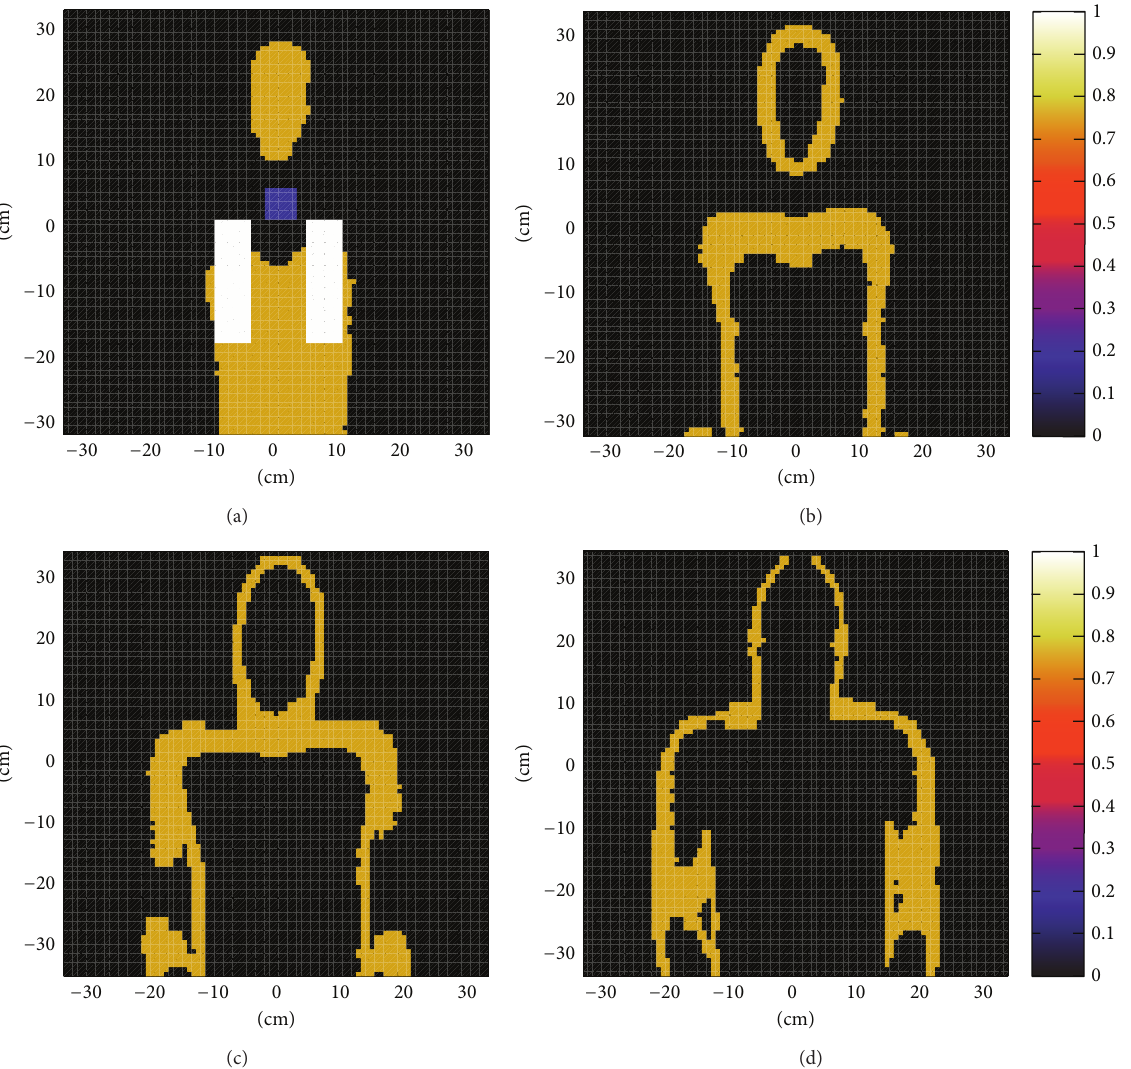
Figure 4: Projected images of the person under test, used as ground truth by the imaging algorithm, at four different ranges: (a) 𝑥 0 + 0 mm, (b) 𝑥 0 + 30 mm, (c) 𝑥 0 + 60 mm, and (d) 𝑥 0 + 90